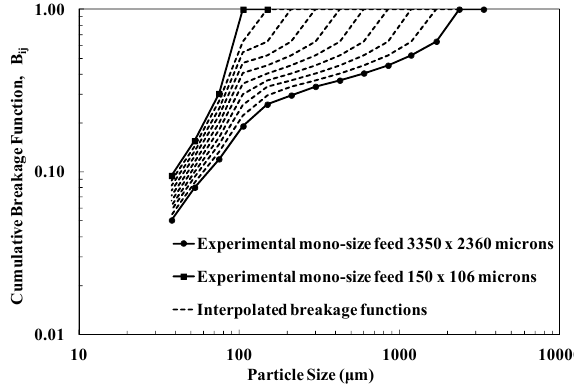
Figure 5. Experimental and interpolated breakage functions for wet grinding in the 25.4 cm diameter mill.